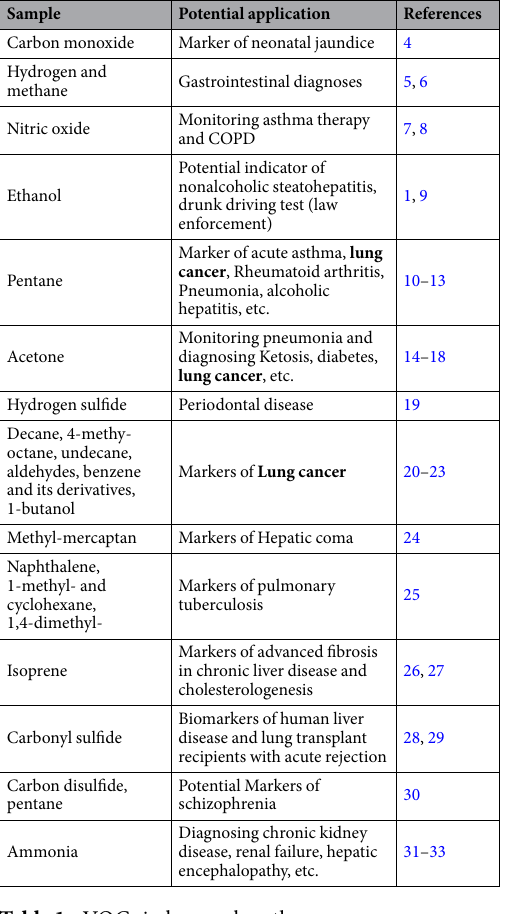
Table 1. VOCs in human